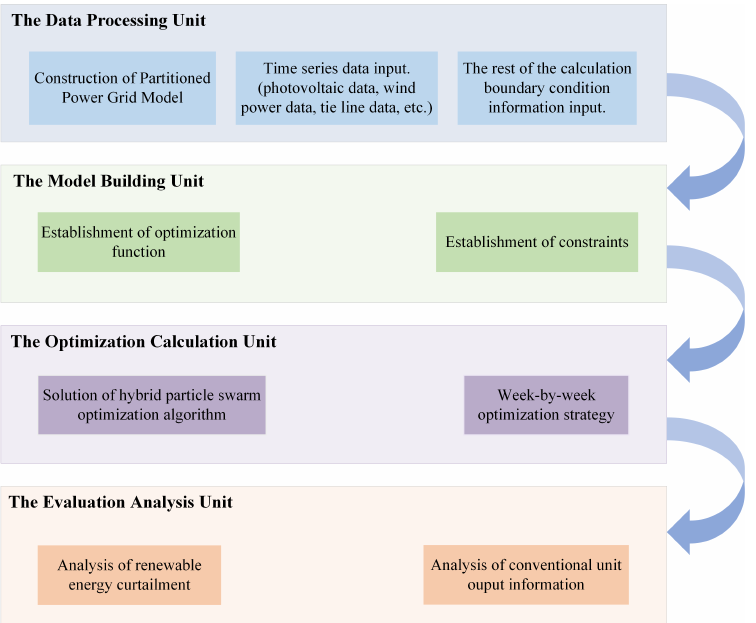
Figure 2. Structure diagram of the calculation method of the renewable-energy accommodation